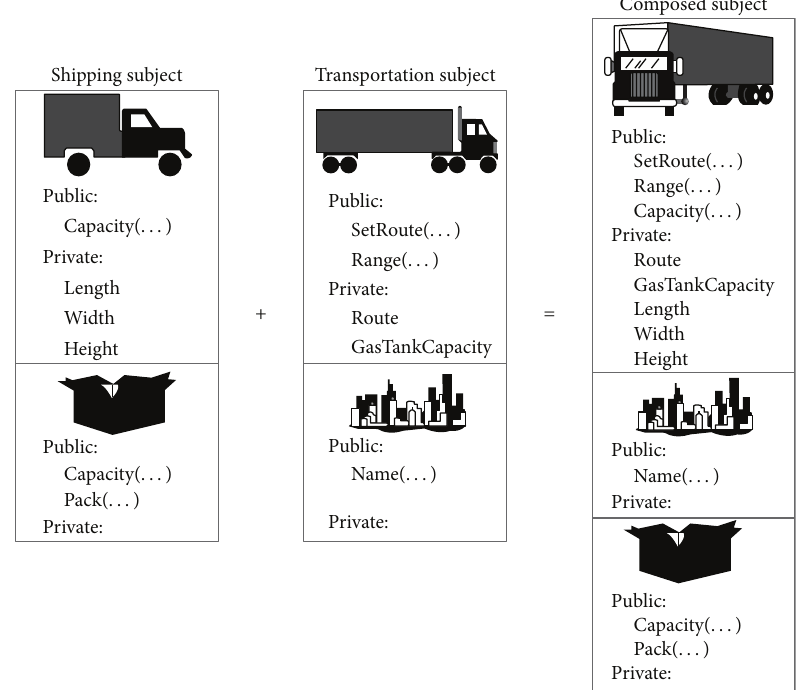
Figure 3: Application suite formed by composition of shipping and transportation subjects